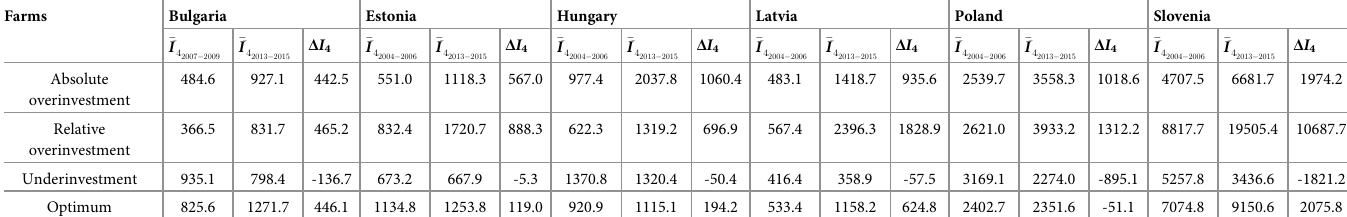
Table 5. Value of fixed assets other than land, calculated per hectare of agricultural land (EUR/ha), in farms grouped by scale of investment in 2007–2009 and 2013–2015 ( I 4